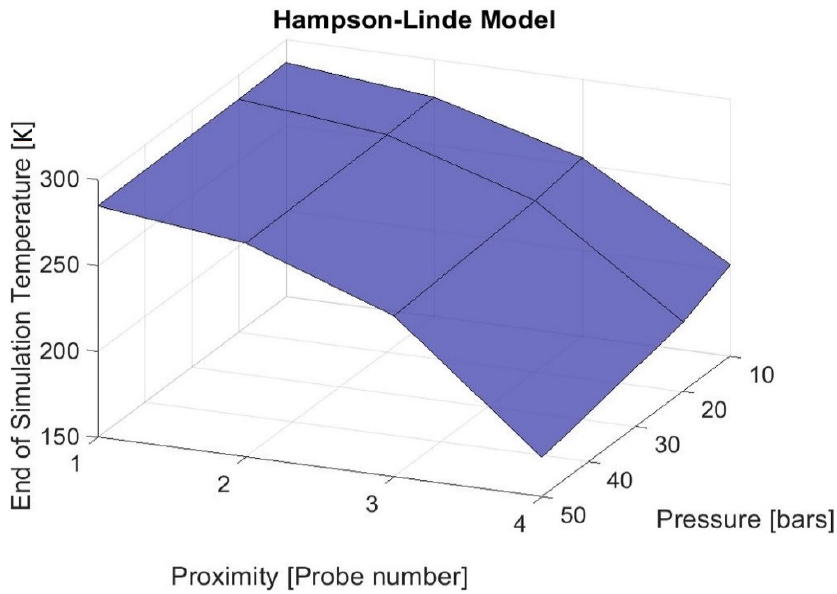
Figure 21. End of simulation temperature values for probes P2.1 to P2.4 function of input pressure and proximity towards the decompression point. An increase in proximity corresponds to an even closer probe towards the Joule ‐ Thomson throttle valve.